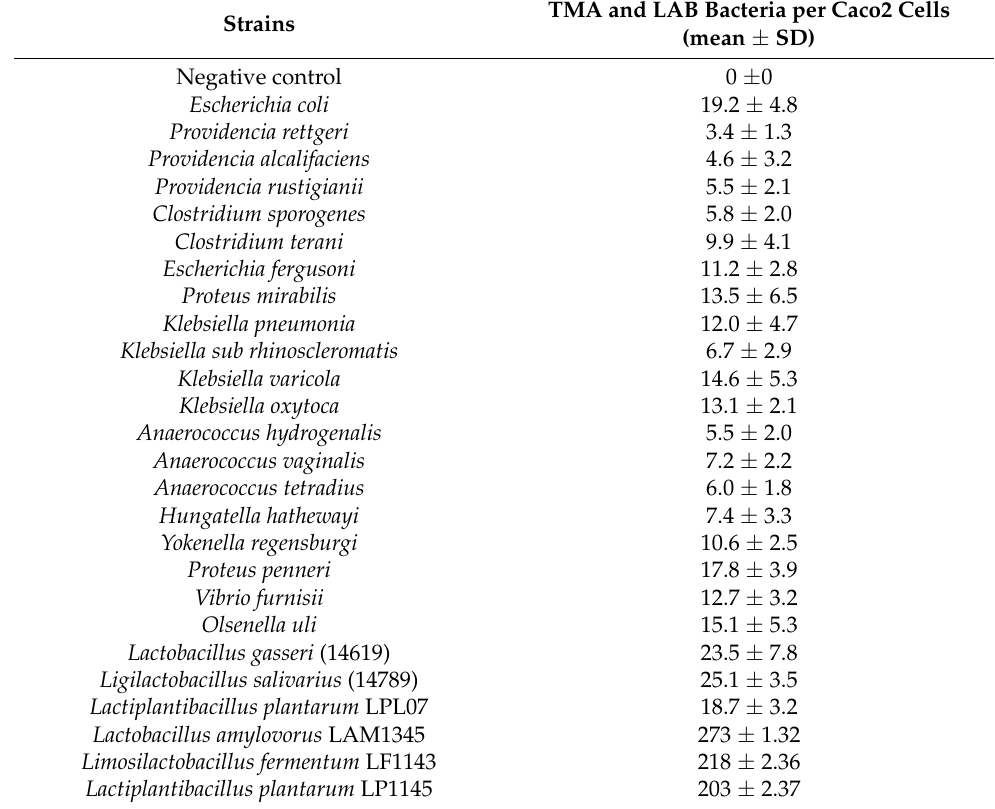
Table 6. Adhesion of TMA and LAB bacteria to Caco2